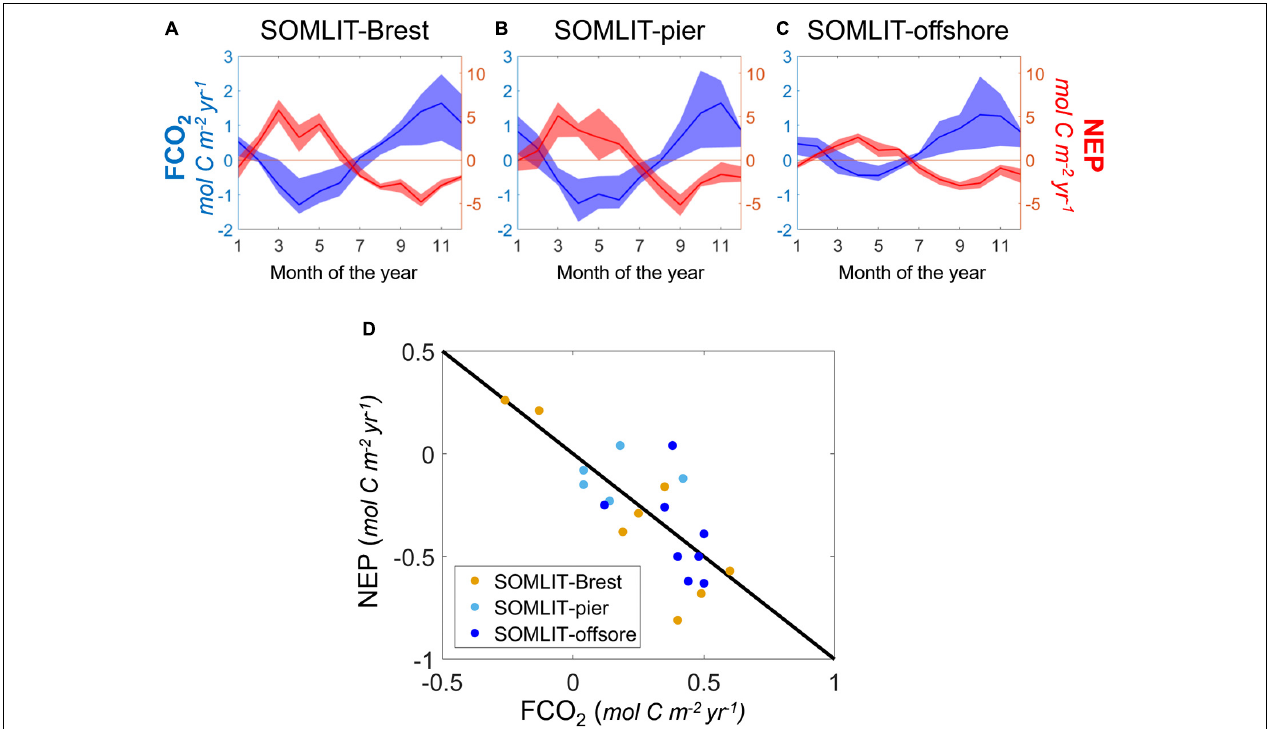
FIGURE 9 | Monthly average of FCO 2 (blue, mol C m - 2 year − 1 ) and NEP (red, mol C m - 2 year − 1 ) at (A) SOMLIT-Brest, (B) SOMLIT-pier, and (C) SOMLIT-offshore. Shaded areas represent the quartiles of the annual means. (D) NEP vs. FCO 2 annual means at SOMLIT-Brest (orange), SOMLIT-pier (light blue), and SOMLIT-offshore (dark blue), from January 2010 to December 2017. The black line represents the 1:1 relationship.